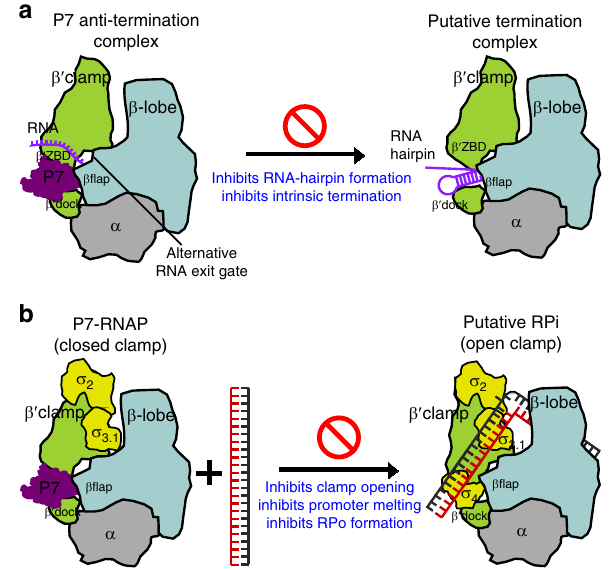
Fig. 7 Proposed mechanisms for transcription inhibition and antitermination by P7. a P7 inserts into the RNA exit channel, re-directs RNA to exit in